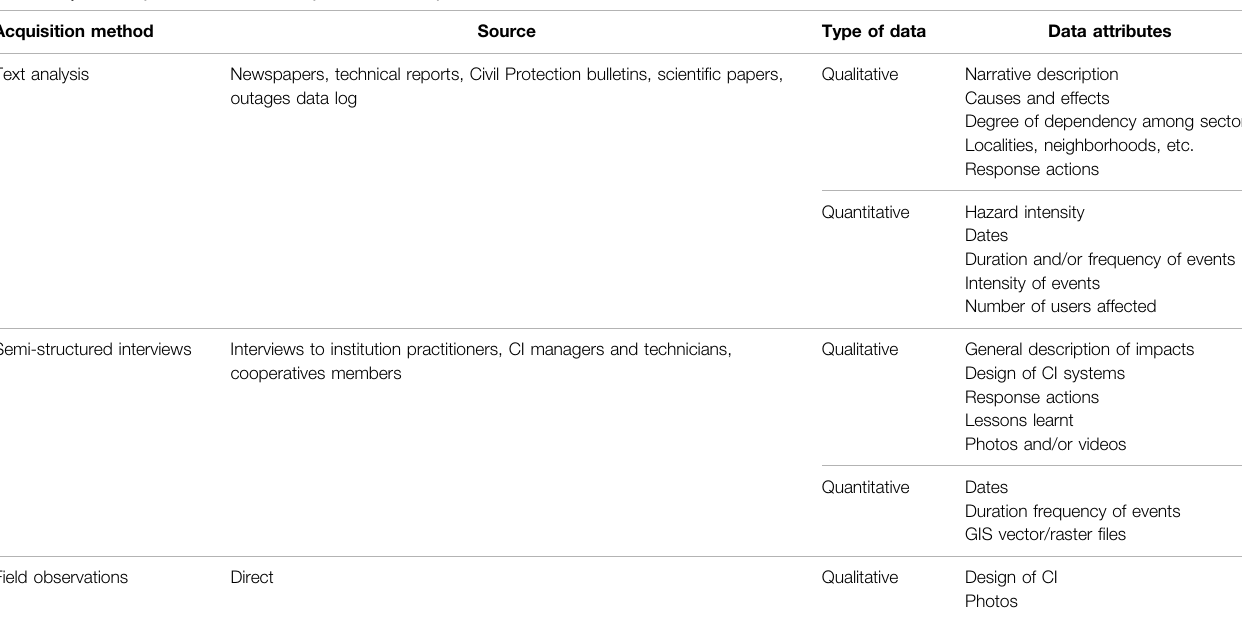
TABLE 3 | Summary of the metadata analysed in this